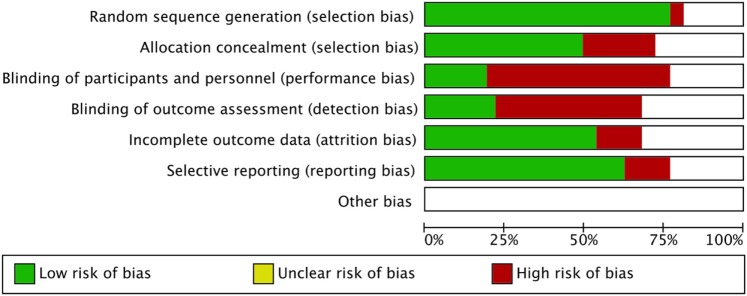
Risk-of-bias graph: the authors’ judgment about each risk-of-bias item is presented as percentages across all included studies.